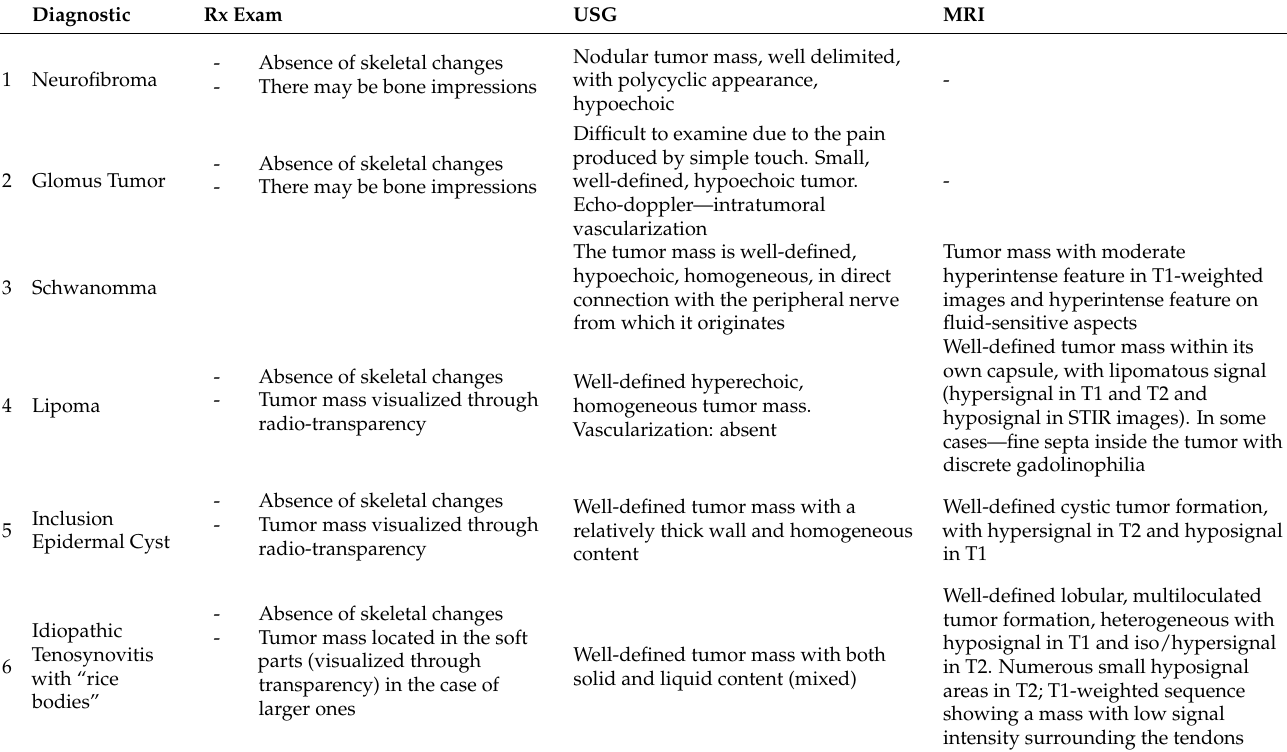
Table 3. The findings of the imaging investigations of the tumors in the study